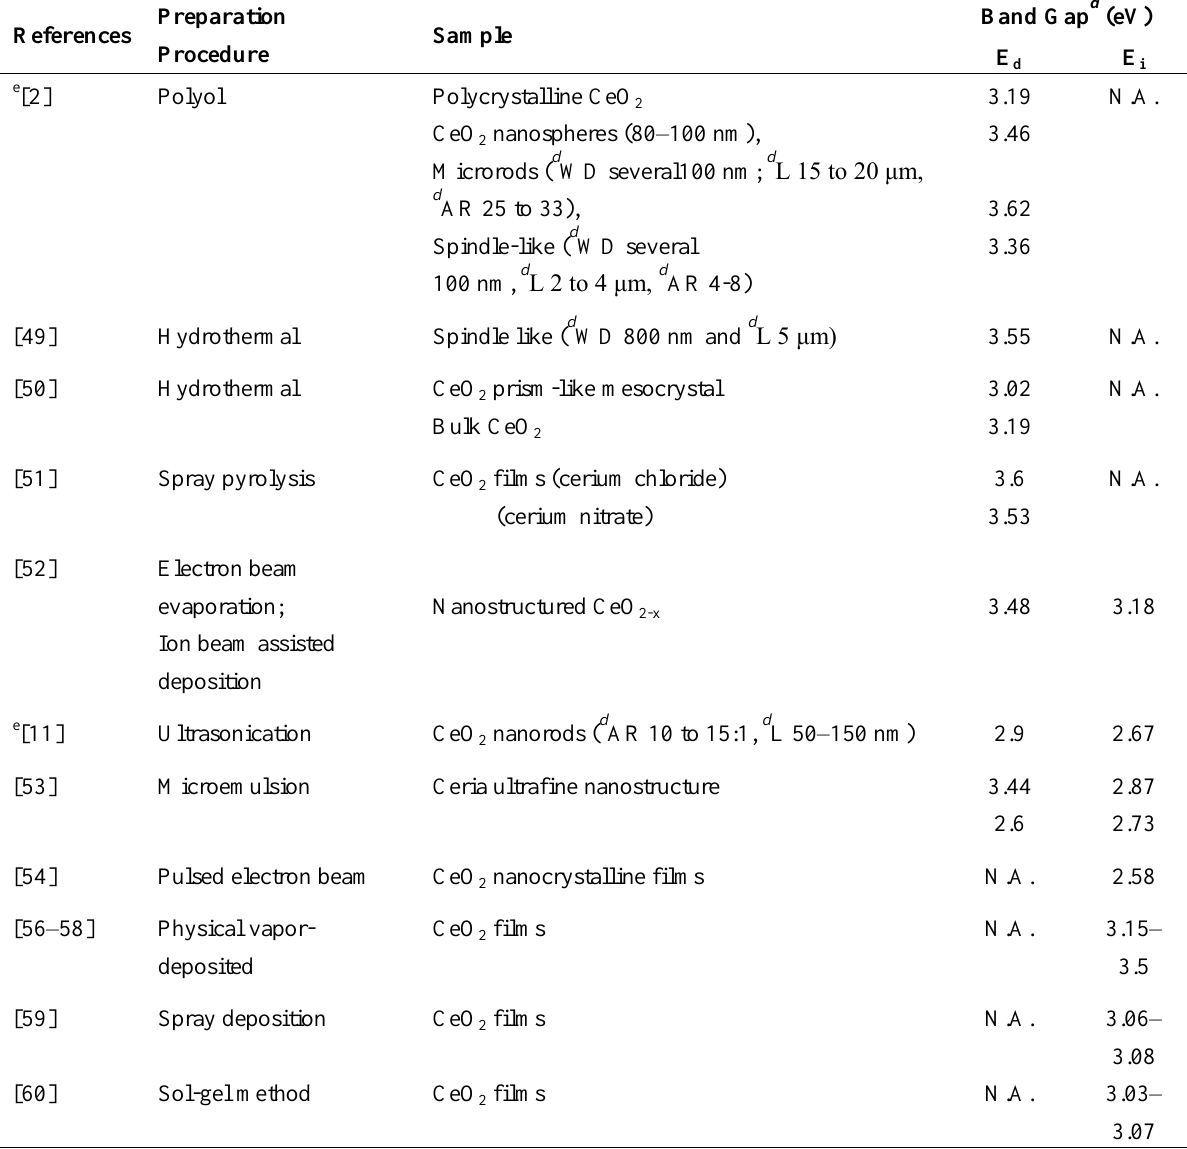
Table 1. Details of the ceria nanomaterials UV-Vis absorption